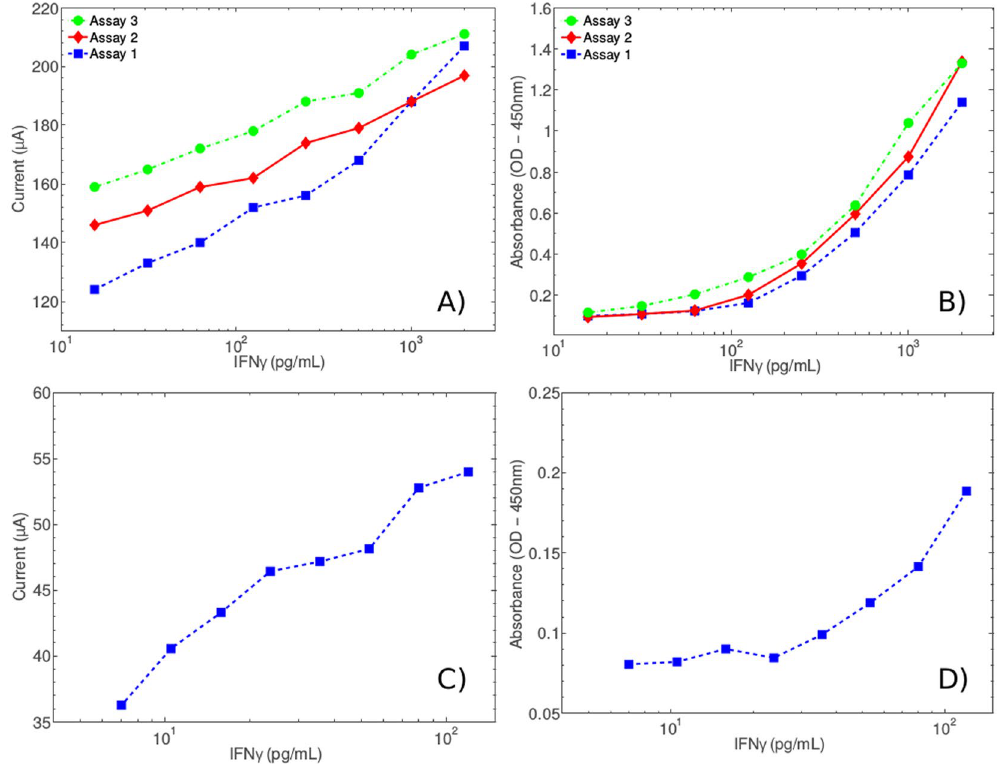
Figure 5. Amperometric assay experiment using the modified assay components measured with the PCB- based sensor. ( A ) Amperometric measurement using the PCB-based sensor and in-house bioinstrumentation platform. ( B ) Colorimetric validation of the experimental results shown in ( A ). ( A , B ) Show three discrete IFN γ titration assays as described in Fig. 1 with amperometric values measured on three discrete sensors and colorimetric values measured on one sensor (Promega Glomax). ( C ) Amperometric data for low concentration IFN γ assay using Log 1.5 analyte dilutions. ( D ) Colorimetric verification of the experimental results